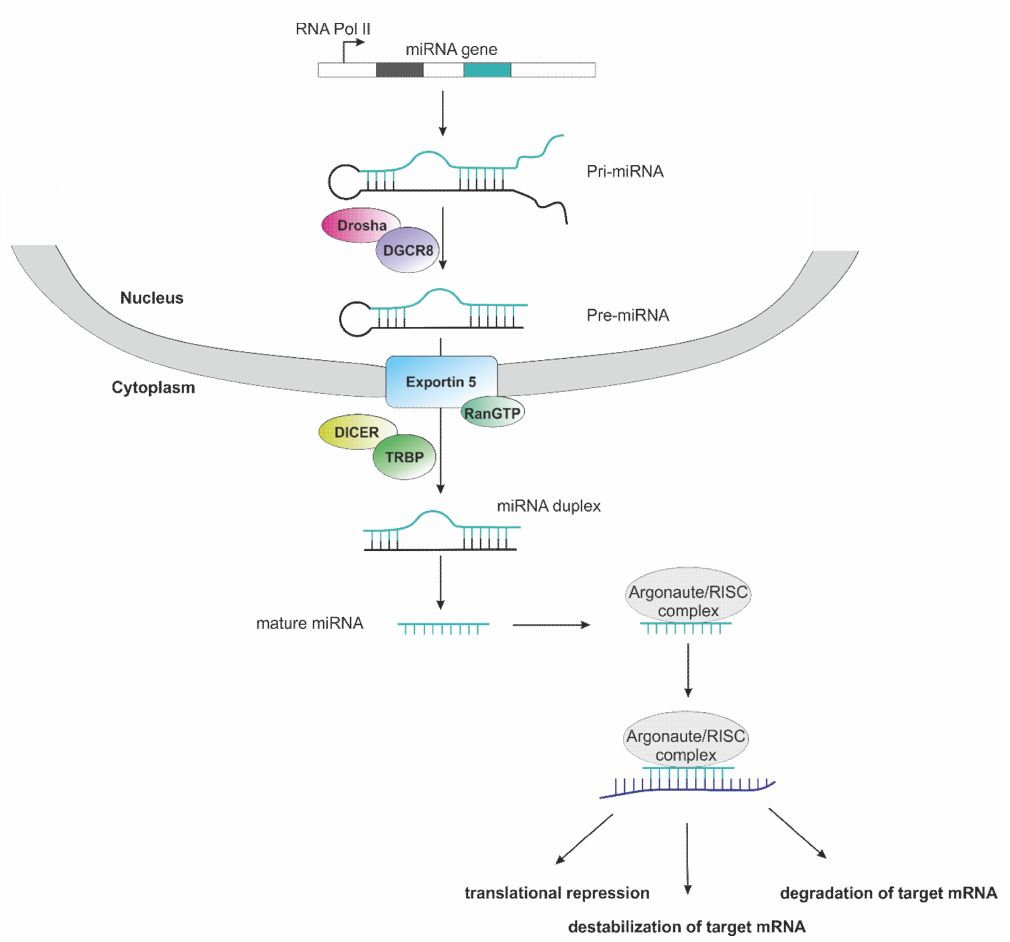
Figure 1. Schematic representation of microRNAs (miRNA) biogenesis and mode of action. Transcription of a miRNA gene is mostly conducted by RNA Polymerase II (pri-miRNA), followed by processing via Drosha / DGCR8 complex into a precursor hairpin miRNA (pre-miRNA). After nuclear export via Exportin 5 / RanGTP, the pre-miRNA is processed by Dicer / TRBP into a miRNA duplex without hairpin. One strand of the mature RNA duplex associates with the Argonaut / RISC complex and guides the whole complex to the target mRNA (violet). Consequences of miRNA binding to the mRNA target are translational repression, destabilization or degradation of the target